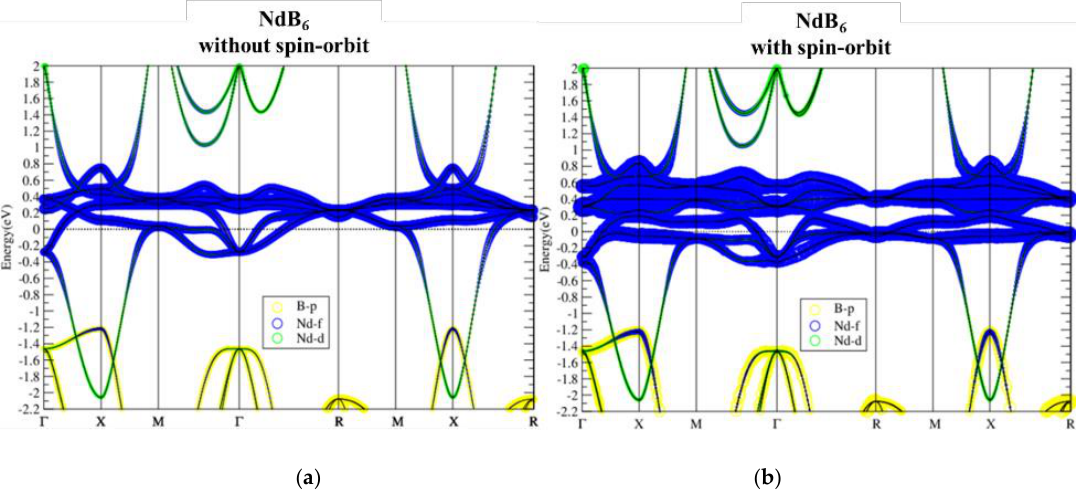
Figure 12. Band structures of NdB 6 without ( a ) and with ( b ) spin-orbit interaction.